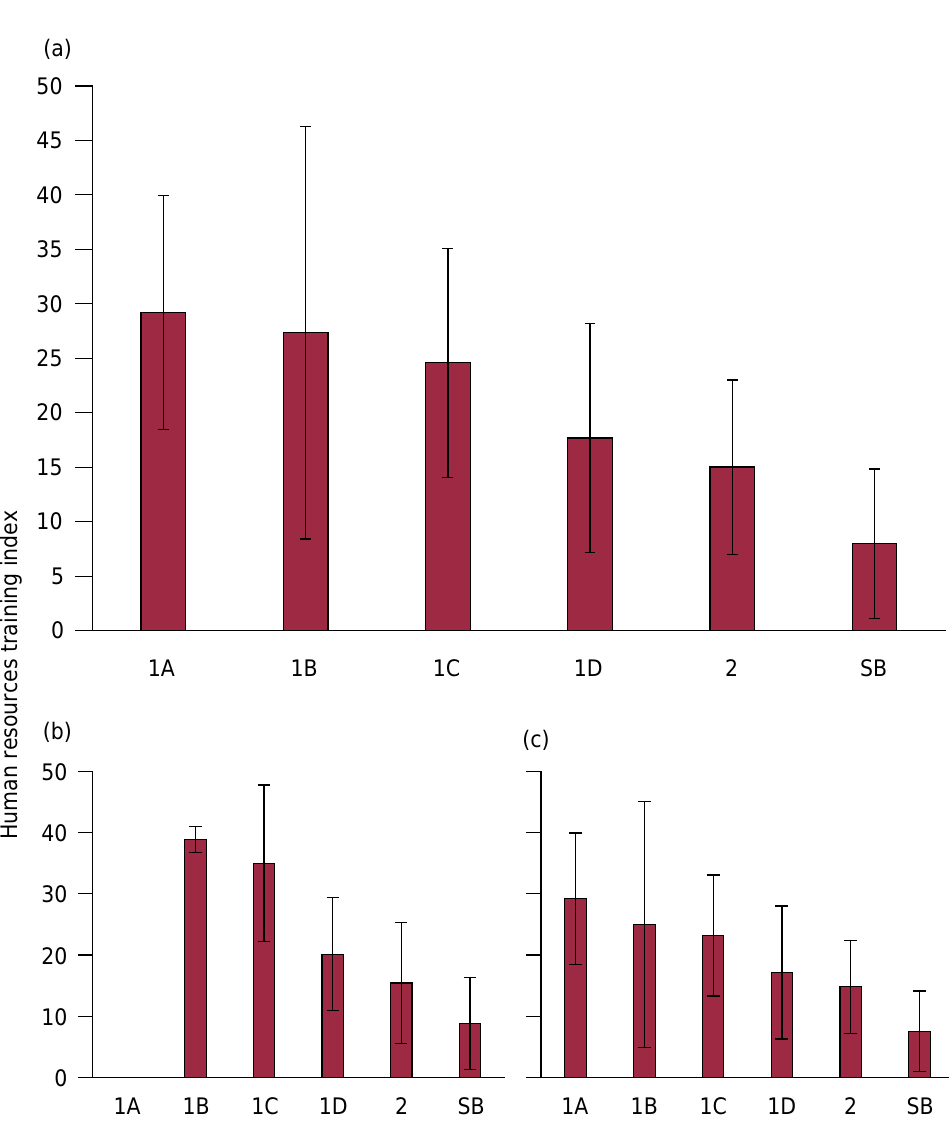
Figure 10. Human resources training index in the last five years (January 2013 to October 2018), by class of PQ fellowship and non-fellows (SB), for all researchers regardless of gender (a) and by gender women (b) and men (c), in CNPq Call